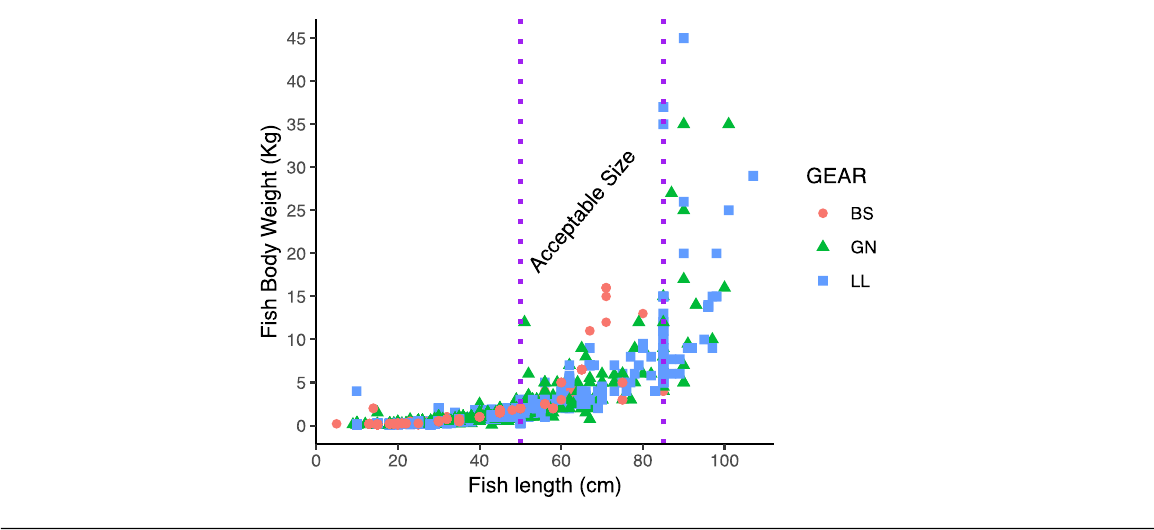
Figure 3: Weight - Length relationship of Nile perch for each fishing gear at Magu